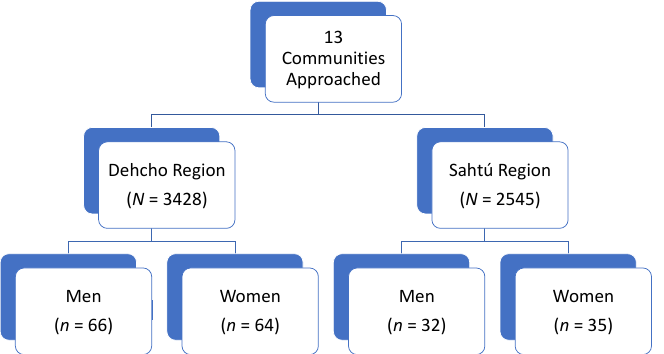
Figure 1. Flow chart of sampling implementation. N = total population of region from 2018 Summary of NWT Community Statistics [34].